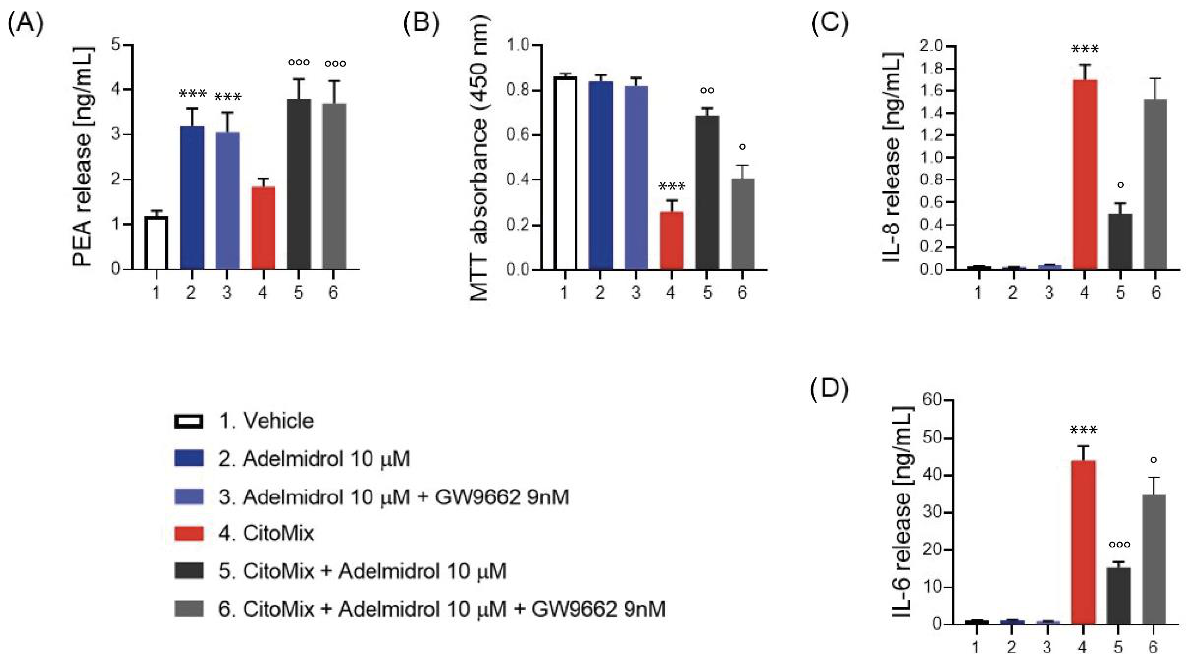
Figure 4. Effect of 24 h incubation of Adelmidrol (10 µ M) on Caco-2 cells in the presence and absence of CytoMix (IFN- γ , 1000 U/mL; TNF- α , 10 ng/mL; and IL-1 β , 1 ng/mL) and in the presence and absence of specific PPAR- γ inhibitor GW9662 (9 nM). ( A ) PEA levels in Caco-2 cells after 24 h incubation. ( B ) MTT absorbance in Caco-2 cells supernatant after 24 h incubation. ( C ) IL-8 and ( D ) IL-6 levels in Caco-2 cells supernatant after 24 h incubation. Results are expressed as mean ± SD of n = 4 experiments performed in triplicate. *** p < 0.001 versus vehicle. ◦ p < 0.05, ◦◦ p < 0.01, and